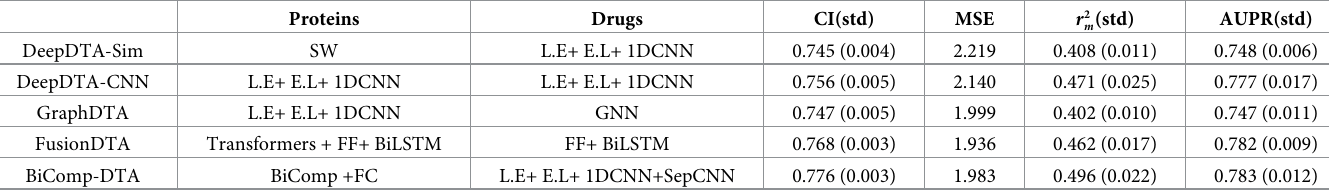
and AUPR values for the BiComp-DTA compared to the alternative methods—PDBbind dataset. m